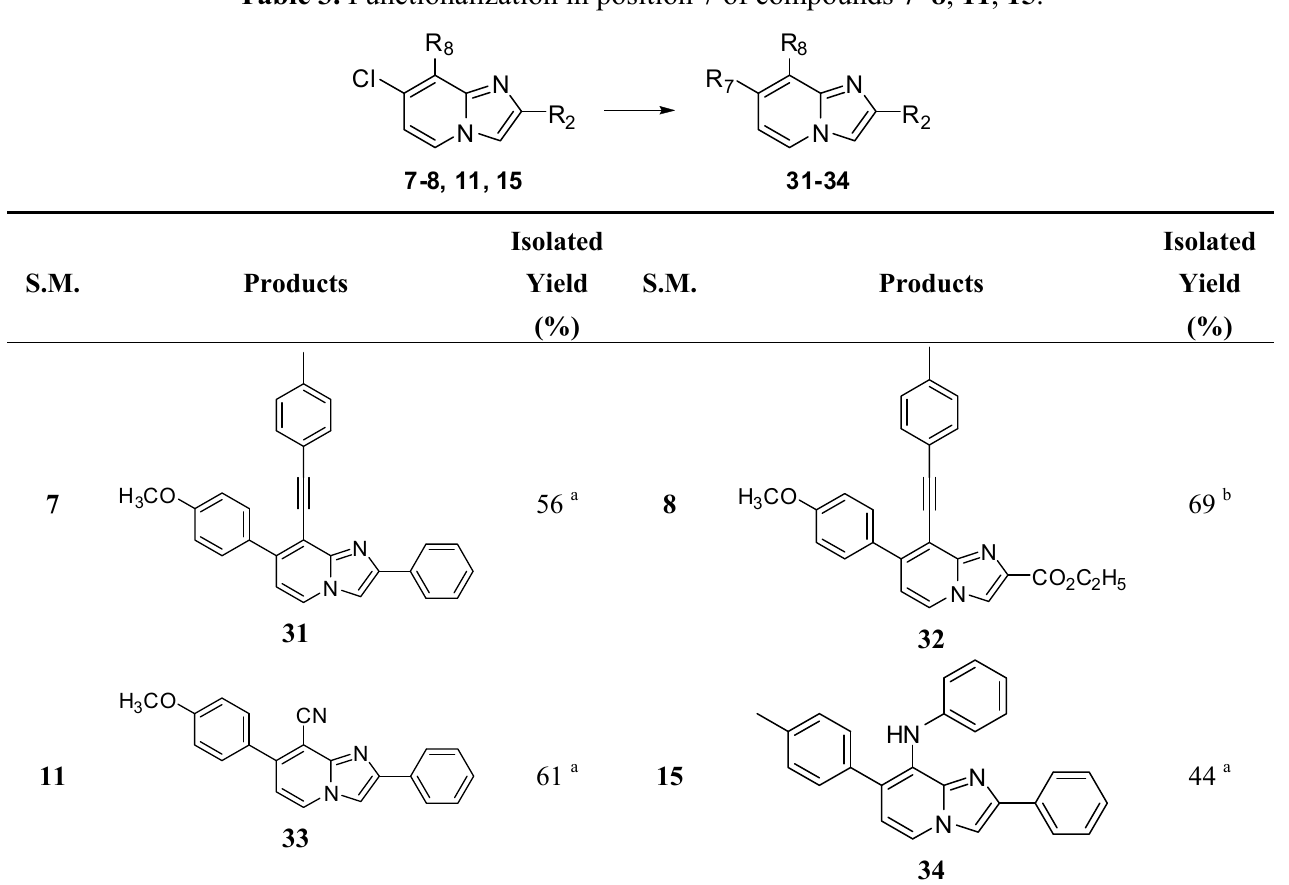
Table 3. Functionalization in position 7 of compounds 7 – 8 , 11 , 15